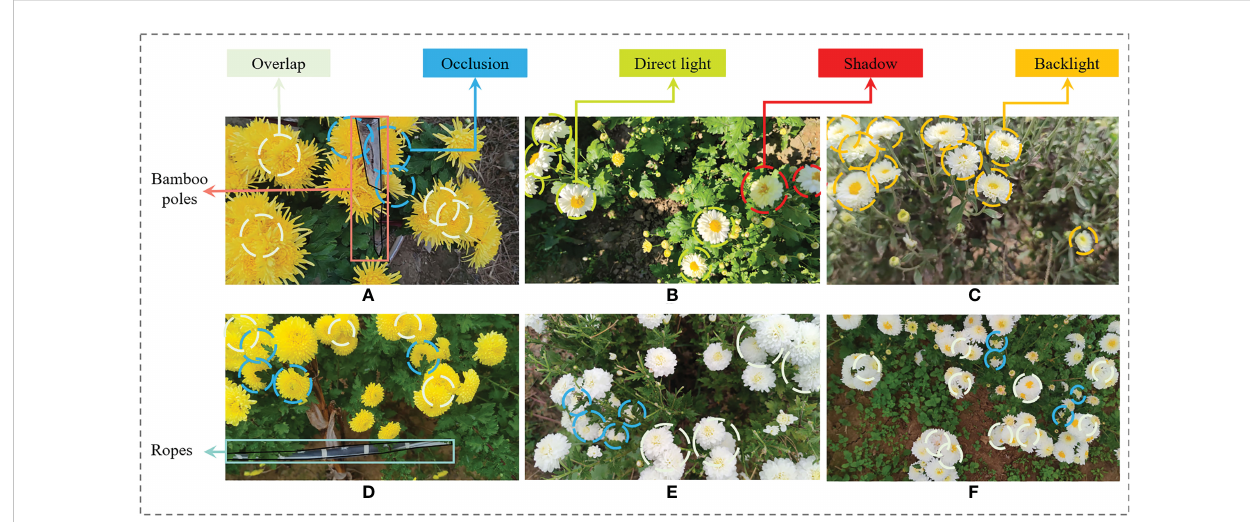
FIGURE 1 The category to which the sample images belong and their number in the related chrysanthemum dataset: (A) Jinsihuangju -01314, (B) Hangbaiju - 00063, (C) Bo-chrysanthemum -11093, (D) Wuyuanhuangju -03285, (E) Gongju -00002, and (F) Chuju